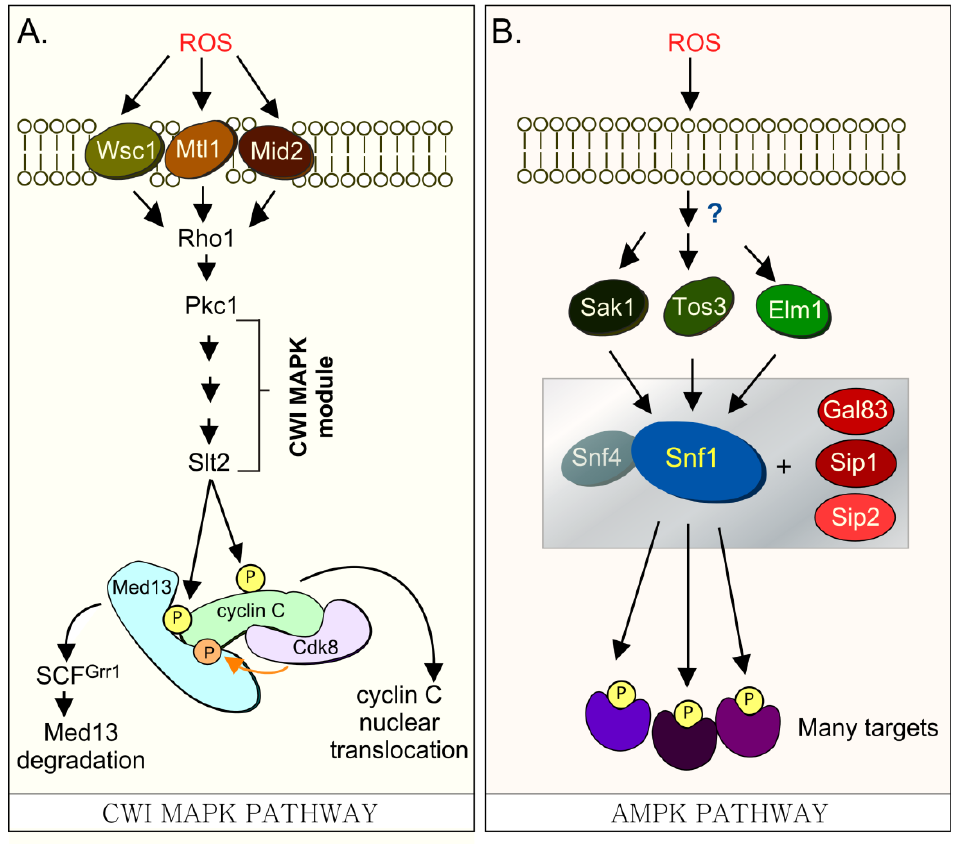
FIGURE 1: (A) Cdk8 module regulation by the CWI MAPK pathway. H 2 O 2 stim- ulates cell wall sensors Wsc1, Mtl1 and Mid2, lead- ing to activation of Rho1 that in turn triggers the cell wall integrity (CWI) MAPK pathway by activating Pro- tein Kinase C (Pkc1). Activa- tion of this cascade triggers